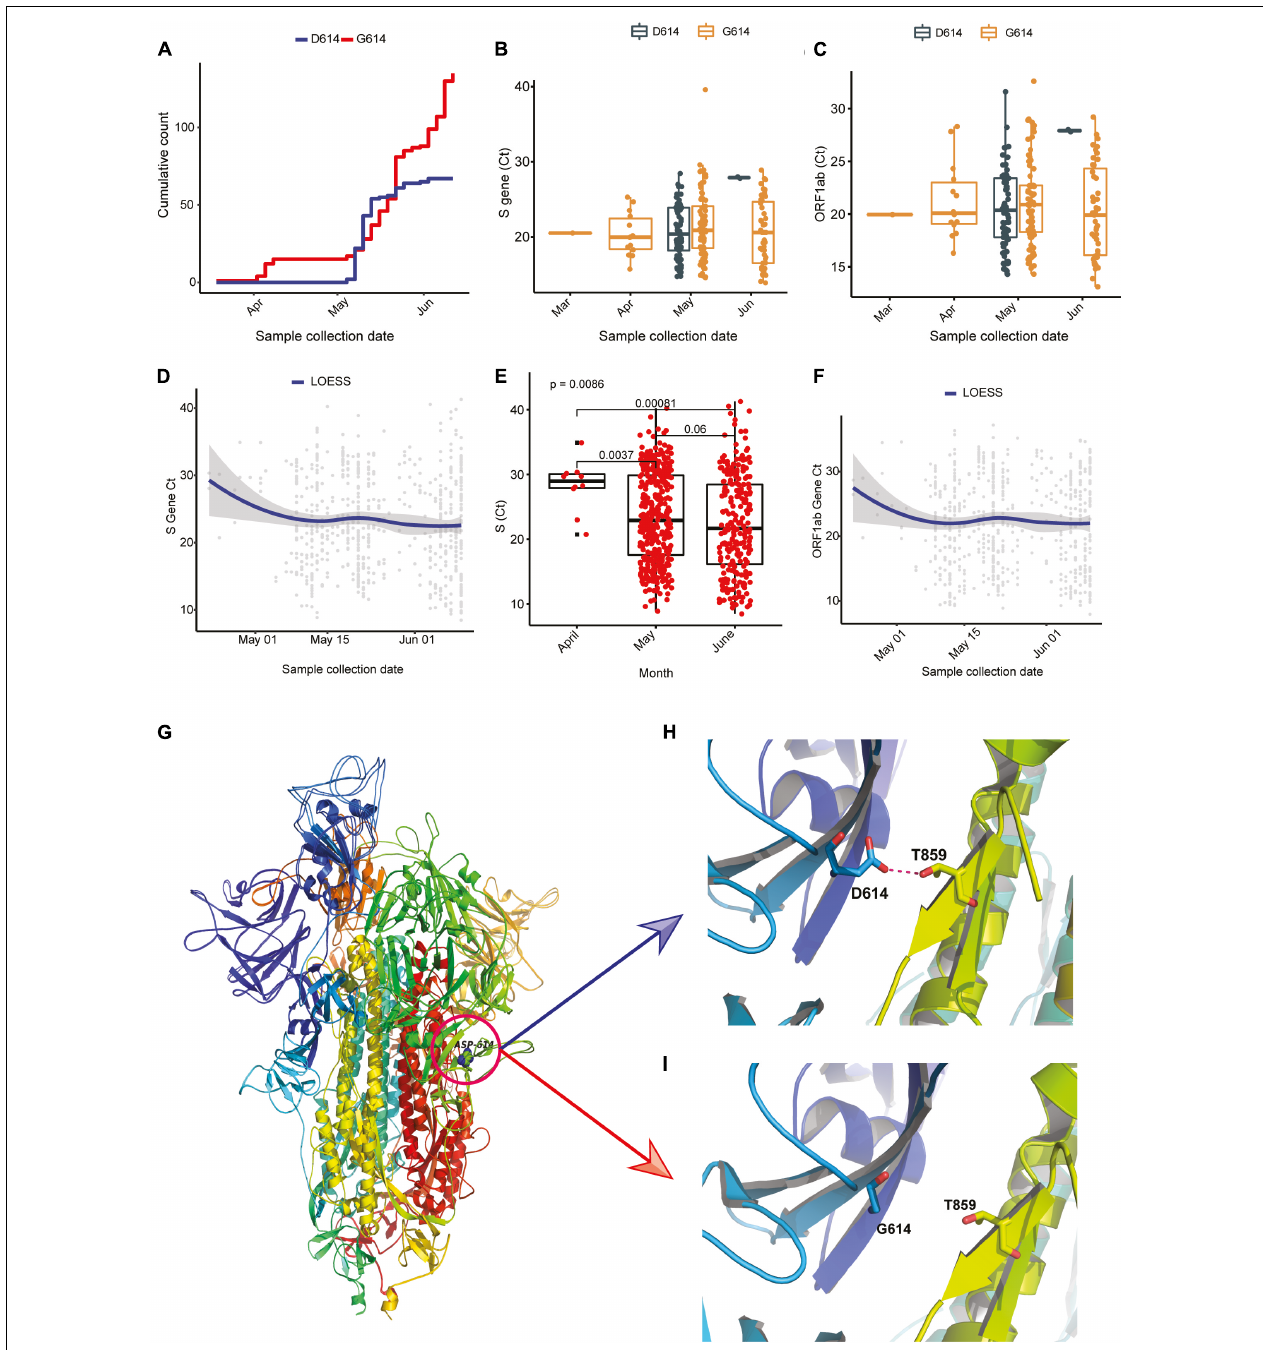
FIGURE 4 | D614G in Spike gene increases infectivity portrayed by Ct values as a surrogate for viral load. (A) Cumulative count of the occurrence of D and G in 614 position of Spike protein in sequenced genomes ( n = 202). (B,C) Ct value distribution of S gene and ORF1ab for the sequenced genomes ( n = 202). (D–F) Ct value distribution of S gene and ORF1ab in all the positive samples tested at Institute of Life Sciences until June 17, 2020. (G–I) The superimposed 3D structures G614 mutant and wild-type Spike protein. (G) The mutant site is highlighted with a circle at 614 position. (H) The hydrogen bond (D614-T859) shown as dotted line between Spike S1 and S2 domain in wild type. (I) The hydrogen bond is lost as a result of D614G mutation.